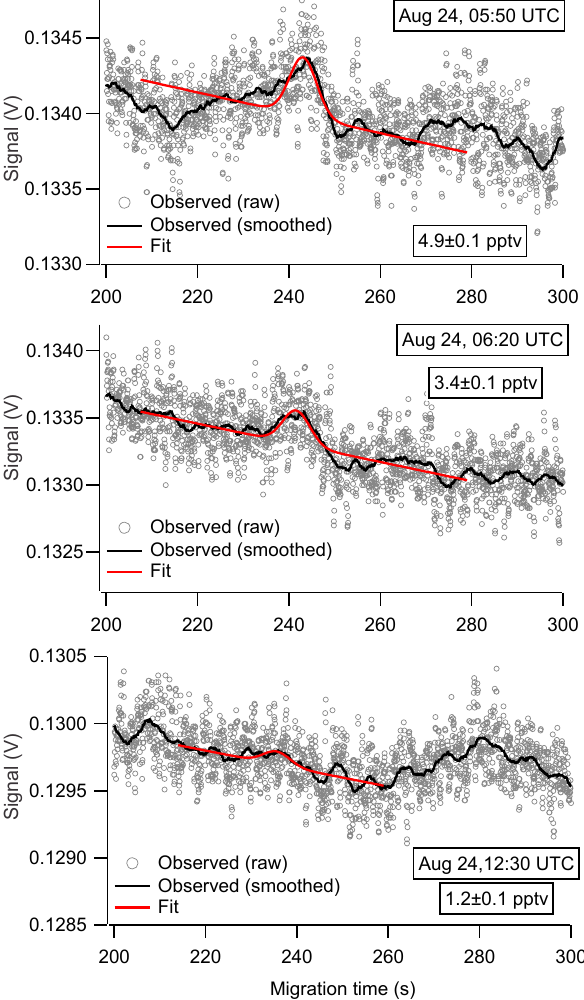
Figure A4. Sample chromatograms of PPN acquired on 24 Au- gust 2013 (analogous to those in Fig. 14) used to estimate the limit of detection for